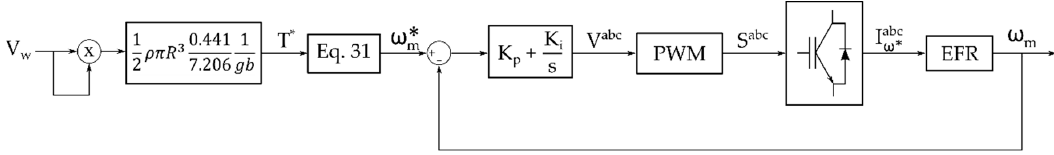
Figure 4. Block diagram of EFR control.